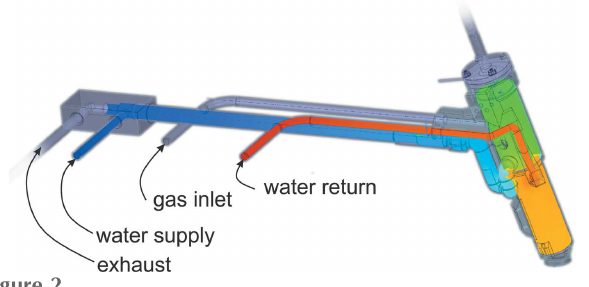
Figure 2 Cooling and gas connections of the heater nozzle. The gas exhaust pipe is surrounded by the cooling water supply (blue), which enters the upper region of the nozzle (green) first, then flows to the lower region where most heat is to be removed (orange) and then leaves the nozzle (red).